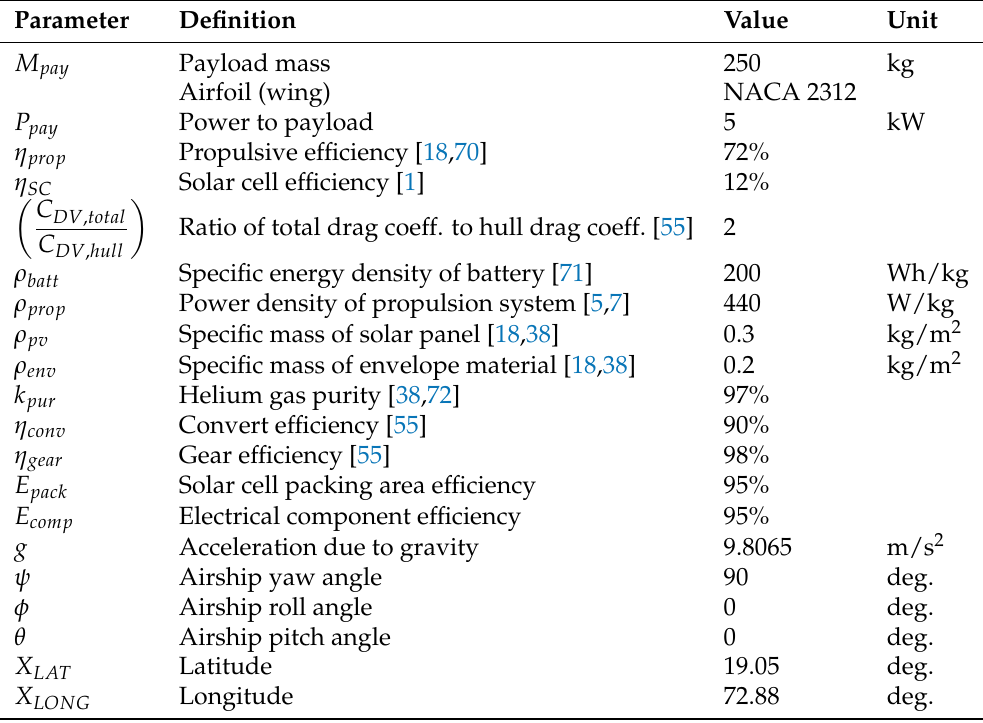
Table 6. List of design constants used in the